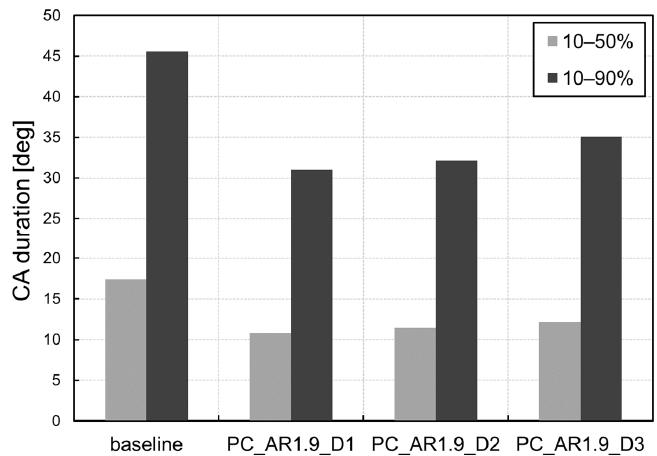
Figure 16. Influence of the orifice diameter on the duration of combustion phase.